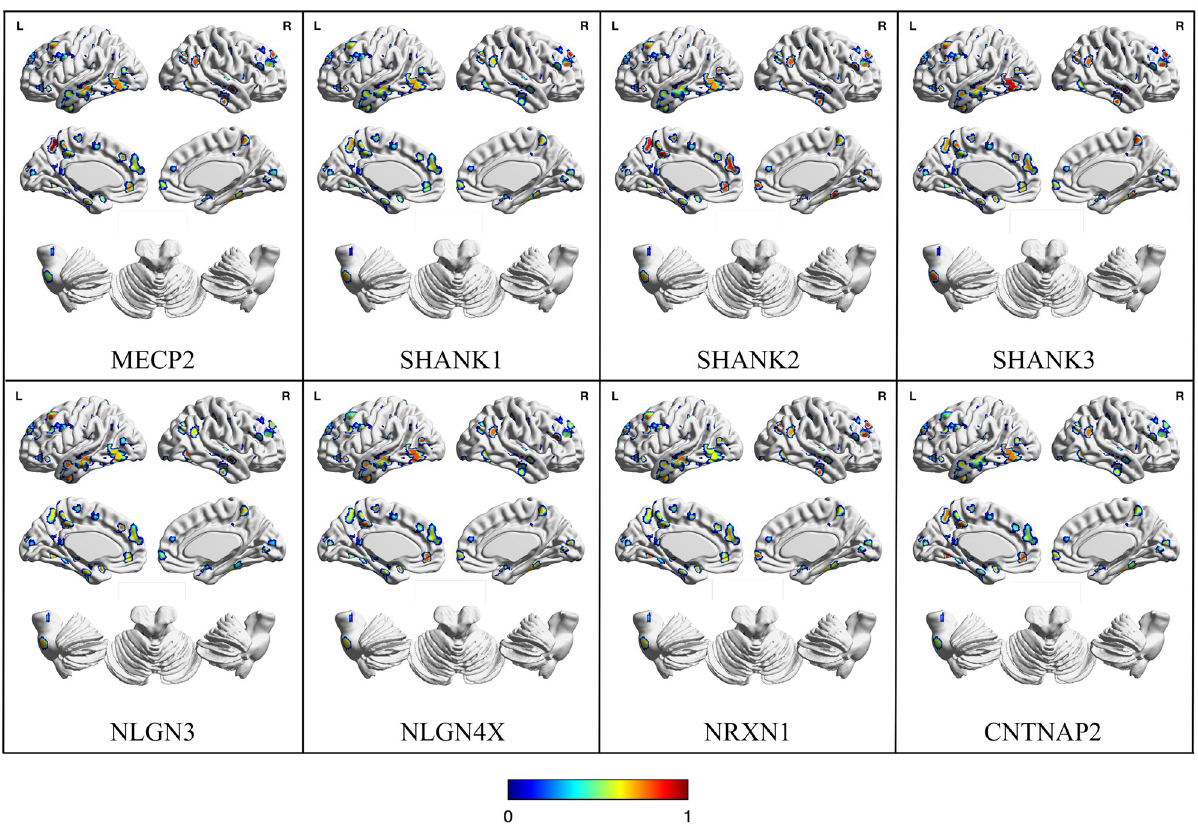
Fig 3. Map with the correlation between gene expression and ALE-derived gray matter increase of each cluster. SMN: Sensorimotor Network, DAN: Dorsal Attention Network, VAN/SN: Ventral Attention/Salience Network, DMN: Default Mode Network, BG/Thal: Basal Ganglia/Thalamus.